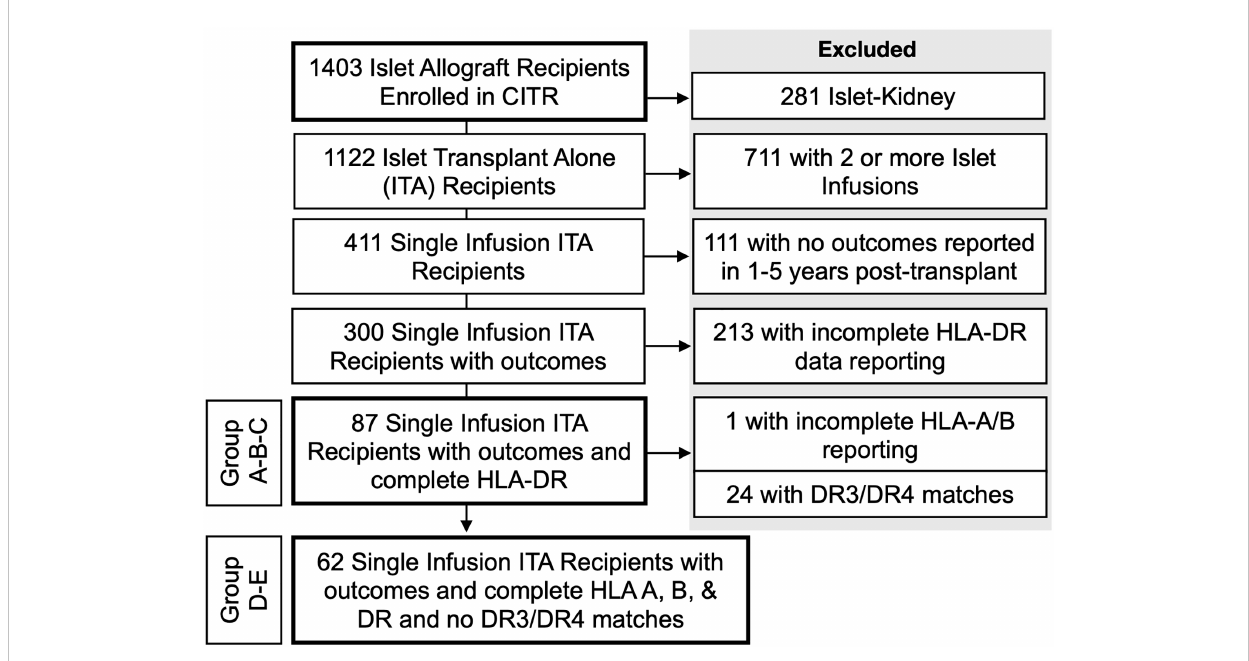
FIGURE 1 Flow diagram of the islet recipients included in this